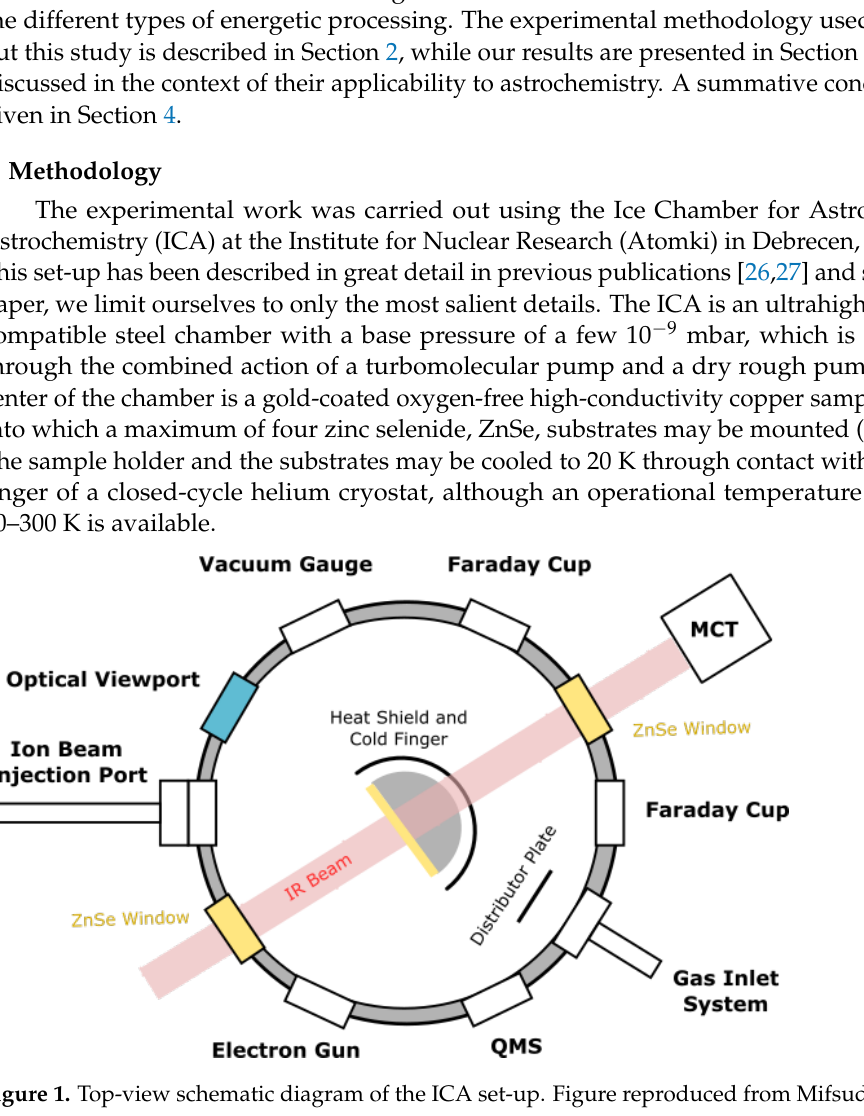
Figure 1. Top-view schematic diagram of the ICA set-up. Figure reproduced from Mifsud et al. [27] with the kind permission of the European Physical Journal (EPJ). with the kind permission of the European Physical Journal